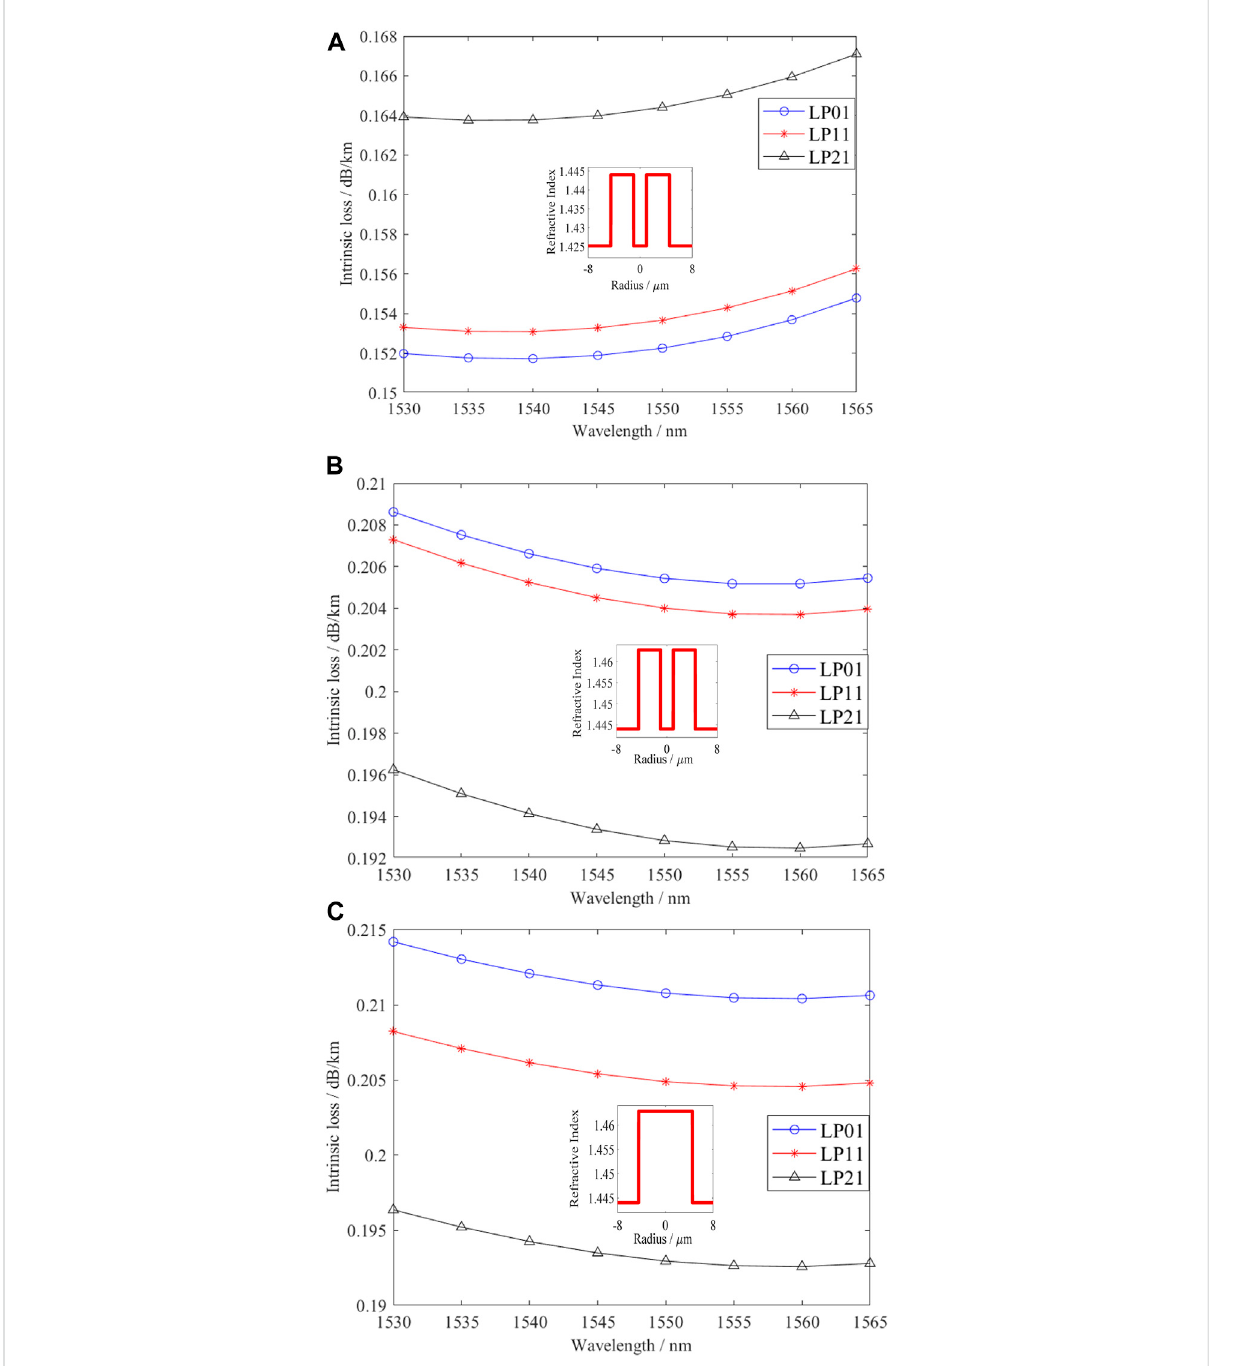
FIGURE 8 Intrinsic loss of the main transmission channel. (A) Intrinsic loss of pure silica FMF ring-core in our MUX/DEMUX. (B) Intrinsic loss of the equivalent FMF with GeO 2 -doped ring-core. (C) Intrinsic loss of the equivalent FMF with the conventional GeO 2 -doped single